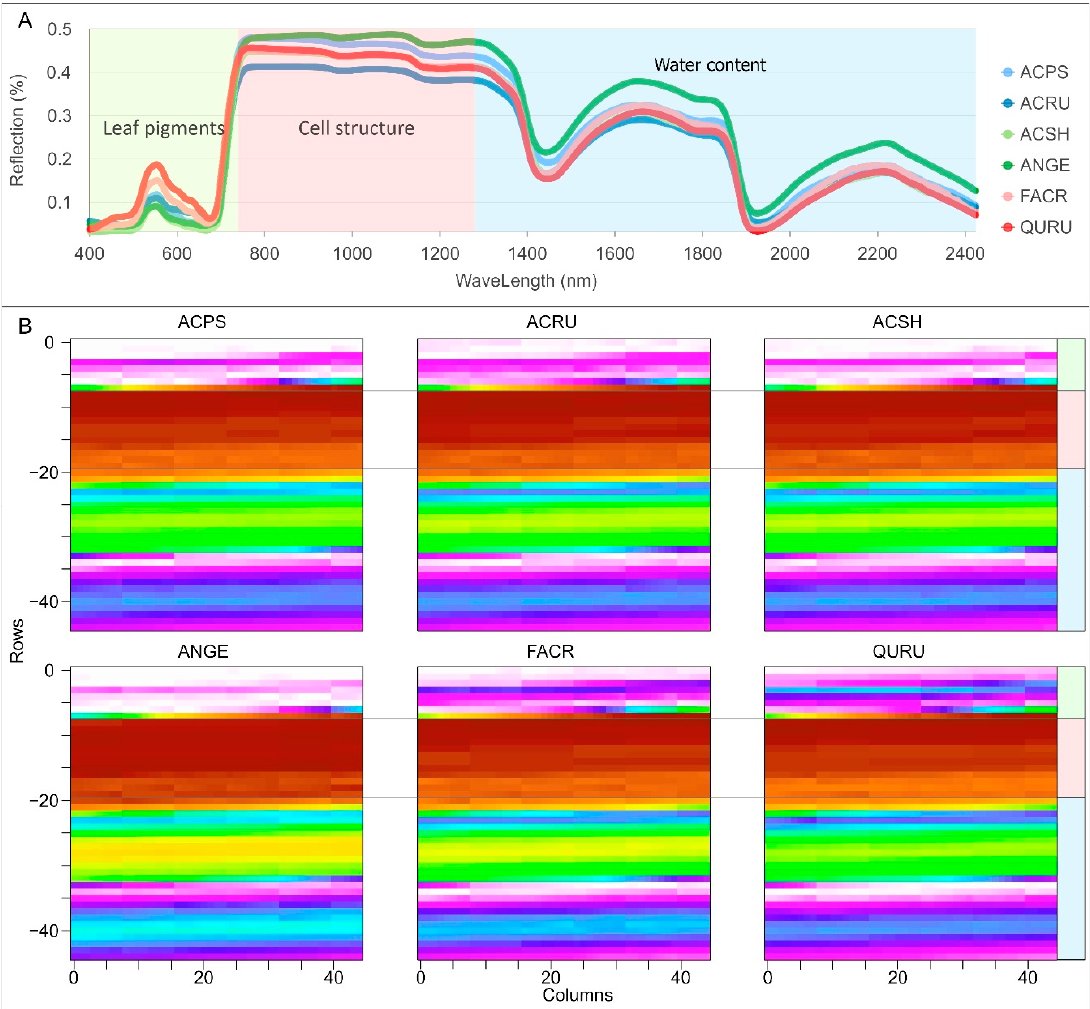
Figure 7. Average reflectance and respective reshaped 2D images of six species. Grey images are colorized for better understanding of reflectance for the reader. ( A ) structure reflectance curve; ( B ) reshaped images (45 × 45).